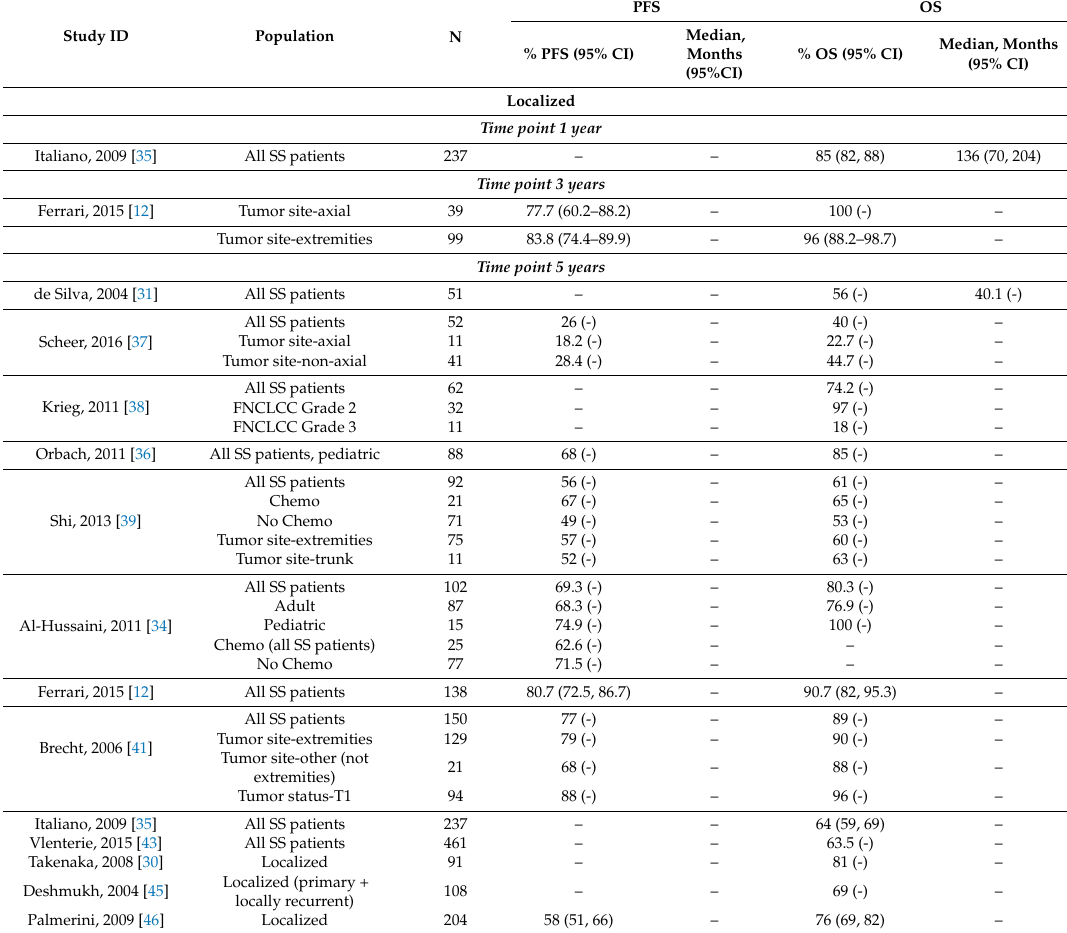
Table 4. Survival